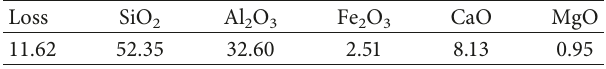
Table 3: The composition of tested